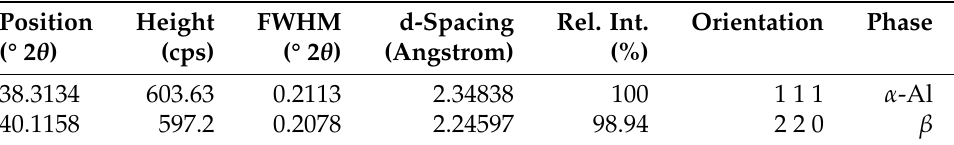
Table 6. Summary of the Rietveld refinement of microdiffraction spectrum in the HAZ of the sample M6 (heat-treated